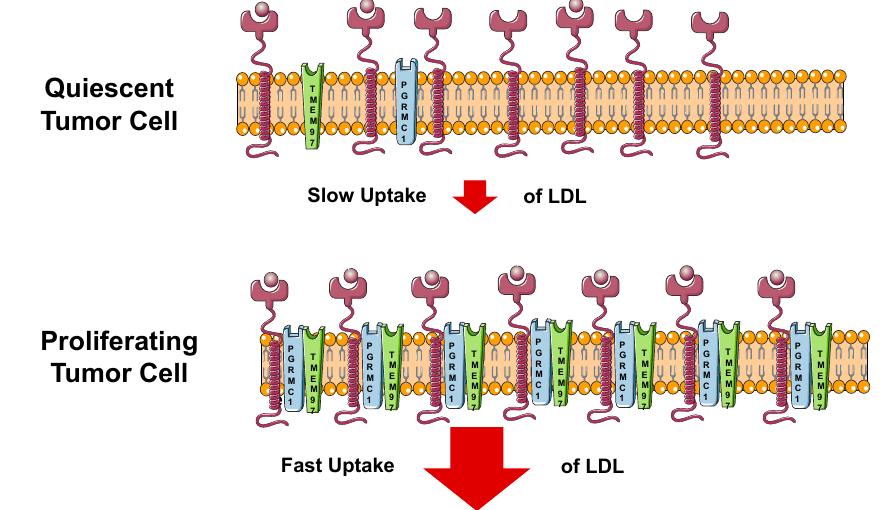
Figure 5. Cartoon showing the mechanism of uptake of the low density lipoprotein (LDL) in quiescent (slow) and proliferating (fast) tumor cells.